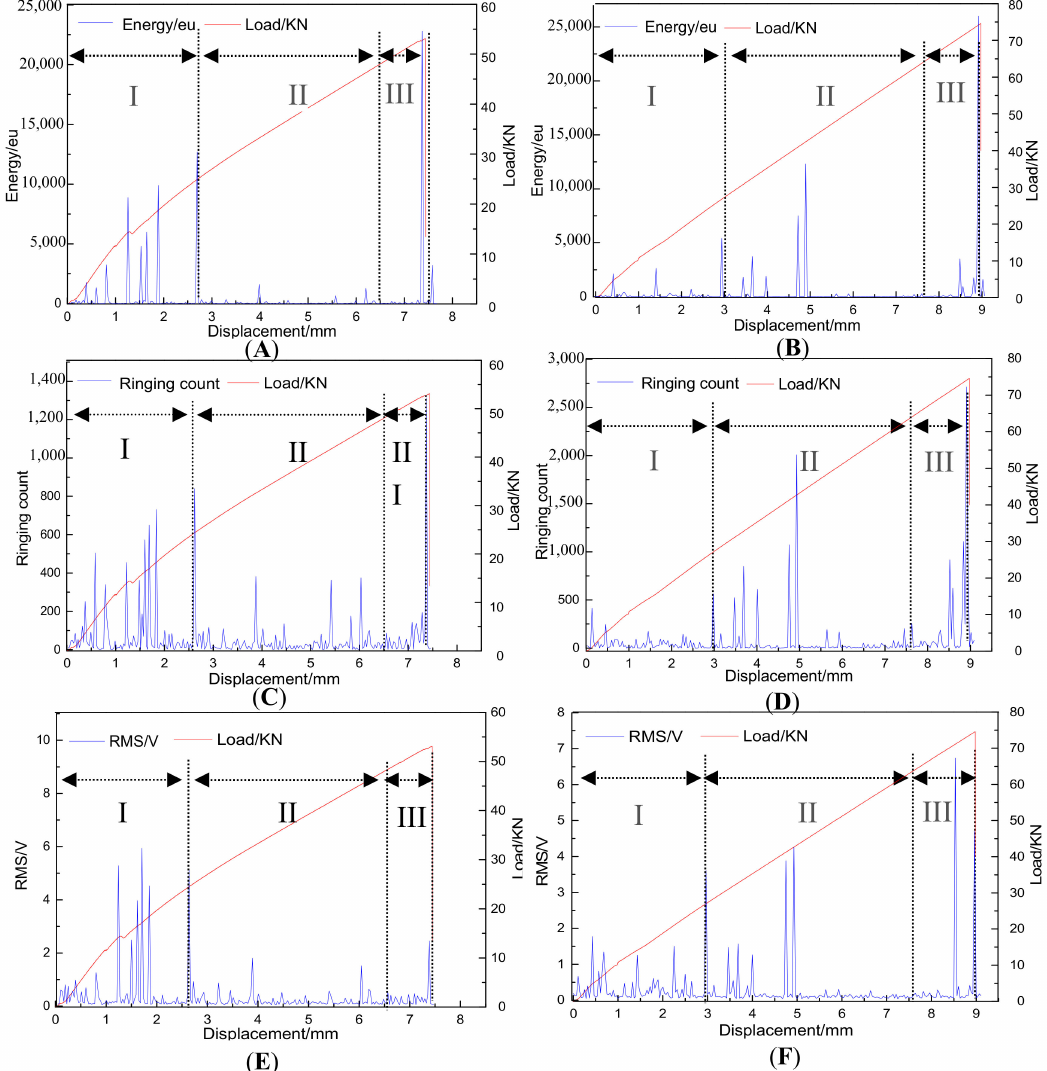
Figure 9. Changes in the load–displacement curves corresponding with the AE signal parameters of specimens B-V2 and B-V3. Change in the load–displacement curve corresponding with AE signal energy parameter of ( A ) B-V2 and ( B ) B-V3. Change in the load–displacement curve corresponding with the AE signal ringing count parameters of ( C ) B-V2 and ( D ) B-V3, and changes in the load–displacement curve corresponding with the AE signal RMS parameter of ( E ) B-V2 and ( F )